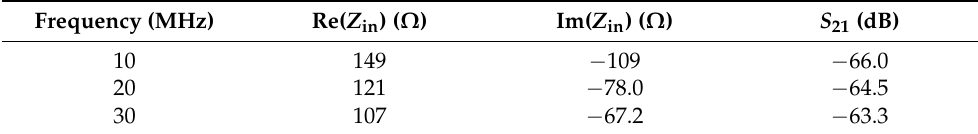
Figure 7. Electric field distributions around and inside the head model with the two-electrode transceiver at ( a ) 10 MHz, ( b ) 20 MHz, and ( c ) 30 MHz. Table 3. Simulation results of the two-electrode transceiver.